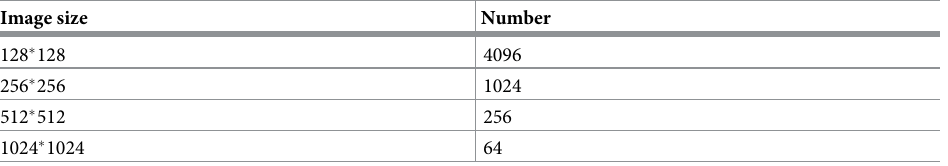
Table 1. Number of training samples for different image